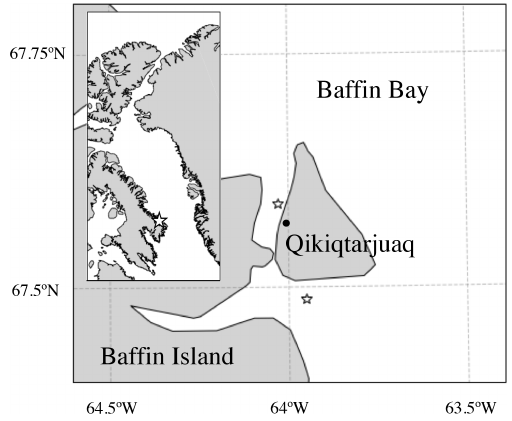
Figure 5. Locations of the snow-covered and bare-ice sampling sites visited on 8 and 9 May 2019 near Qikiqtarjuaq on the shore of Baffin Bay in Nunavut,